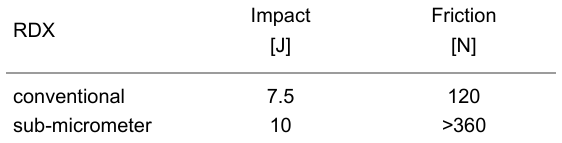
Table 4: Comparison of the sensitivity levels of conventional and 400 nm diameter RDX. RDX